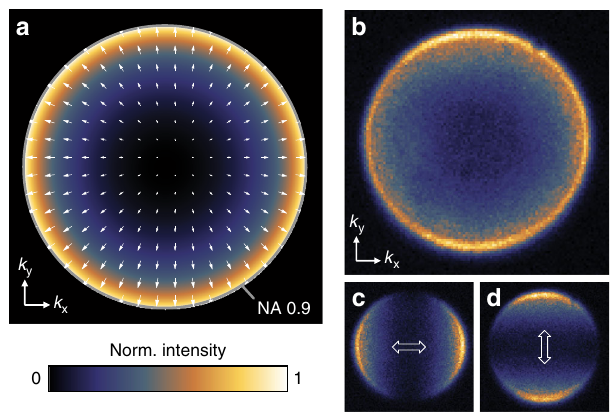
0 Fig. 3 Radiation pattern of vdWQT device emission. a Calculated emission pattern of an electric point dipole located at a distance of 1 nm above a gold half-space, radiating a free space wavelength of 800nm. Arrows indicate the position-dependent orientation of the electric fi eld vector. The maximum value of the in-plane wave vector component k jj ¼ ð k 2 x þ k 2 y Þ 1 = 2 is given by k ||,max = NA × k 0 where NA = 0.9 is the numerical aperture of the objective and k 0 = 2 π / λ . b Measured angular distribution of photons emitted into the upper half-space. c , d As b when measured through a polarizer whose transmitting axis is oriented horizontally/vertically,